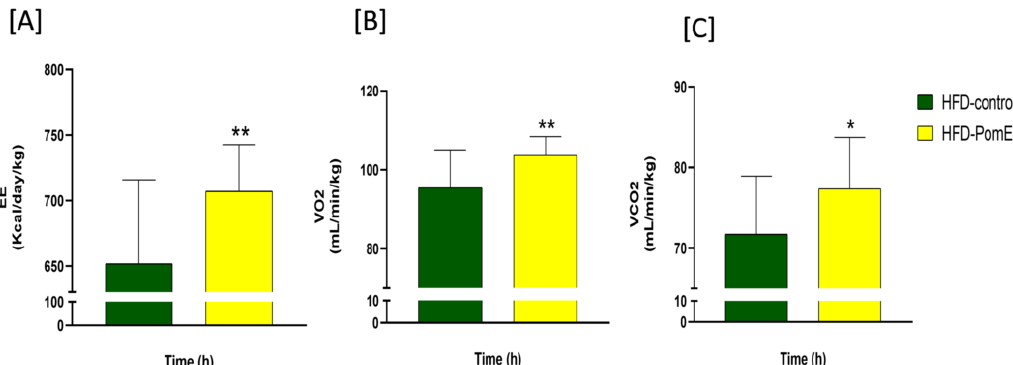
Figure 4. ( A ) Energy expenditure, ( B ) volume of oxygen (VO 2 ), and ( C ) volume of CO 2 (VCO 2 ) parameters in HFD-PomE and HFD-control groups (N = 8). Statistically significant values are indicated with asterisks based on their p- value, * p < 0.05, ** p < 0.01.